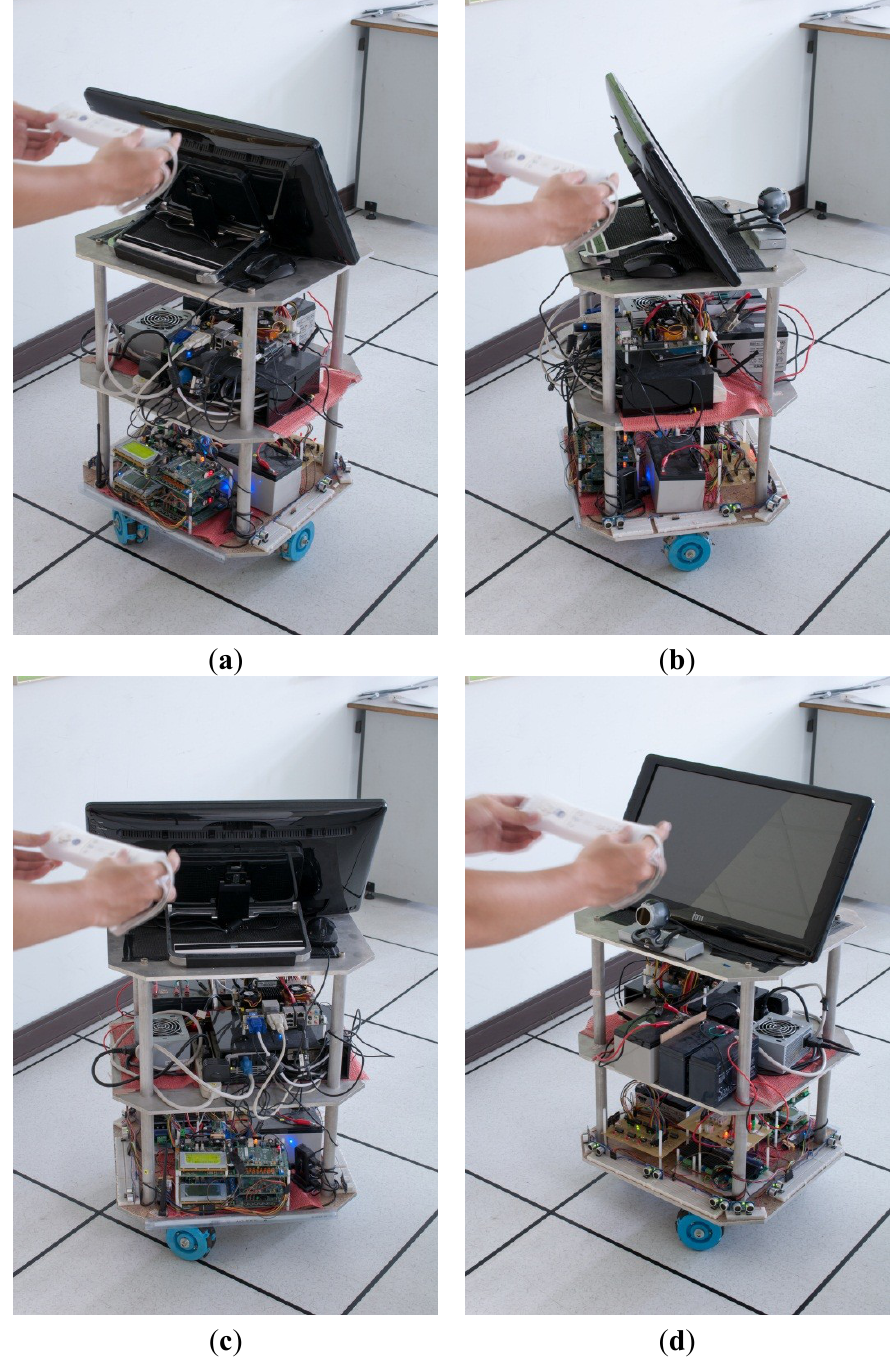
Figure 15. A set of omni-directional mobile experiments. ( a ) Forward, ( b ) turn right, ( c ) turn left, and ( d ) rotate